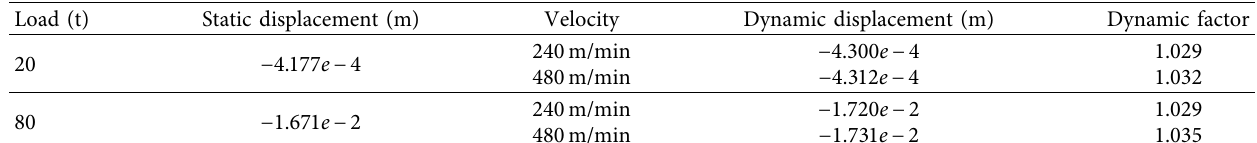
Figure 8: Midspan vertical displacement of girder under different load or velocity conditions: (a) the trolley velocity vt � 240m/min, and (b) the load mass mt � 80t. Table 2: Dynamic coefficient of vertical displacement.